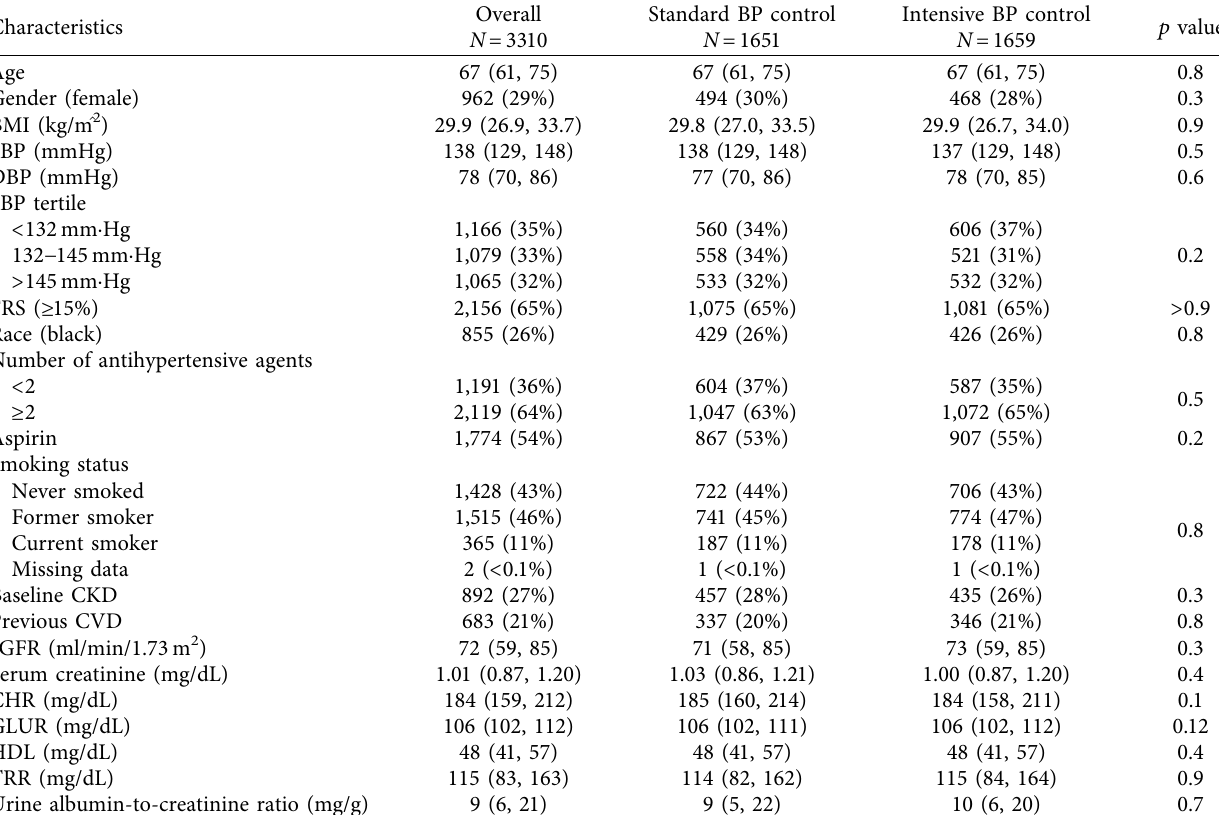
Table 1: Baseline characteristics of study participants.